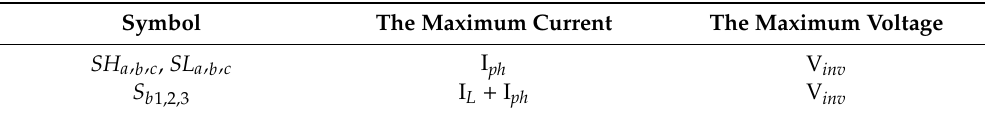
Table 1. Devices